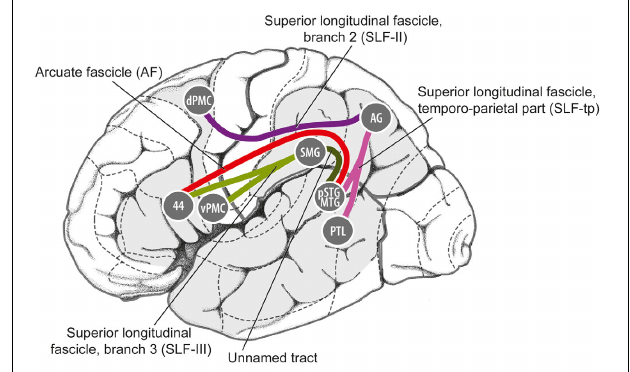
FIGURE 5 | Details of some of the fiber tracts thought to be involved in the dorsal auditory processing stream in humans, from Gierhan (2013). 44, Brodman Area 44; AG, angular gyrus; dPMC, dorsal premotor cortex; pSTG/MTG, posterior superior temporal gyrus/middle temporal gyrus; PTL, posterior temporal lobe; SMG, supramarginal gyrus; vPMC, ventral premotor